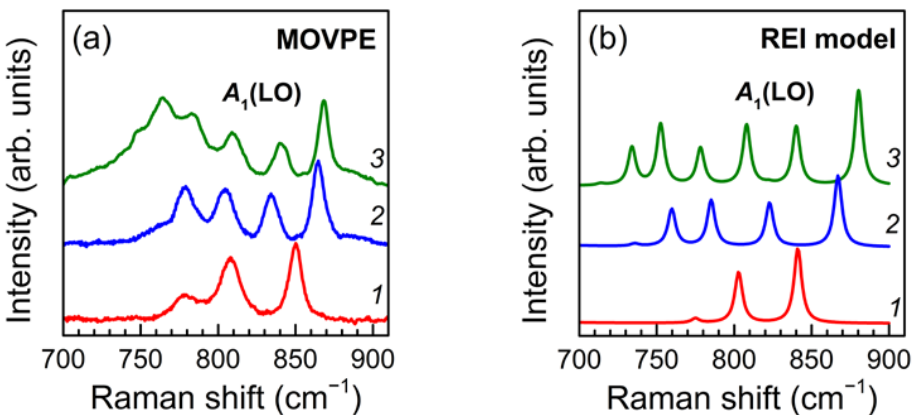
Figure 7. Experimental z ( xx ) z Raman spectra of (GaN) m /(AlN) m SLs grown by MOVPE: ( 1 ) m = 4; ( 2 ) m = 6; ( 3 ) m = 8 ( a ) in comparison with the spectra calculated for the same SLs within the REI model with I = 4, 6, and 6 for m = 4, 6, and 8, respectively ( b ). Additional calculations show that, with a significant interface diffusion, the SL Raman spectrum approaches the spectrum of a digital solid solution: all A 1 (LO) lines merge into one peak corresponding to the A 1 (LO) mode of the solid solution [39].